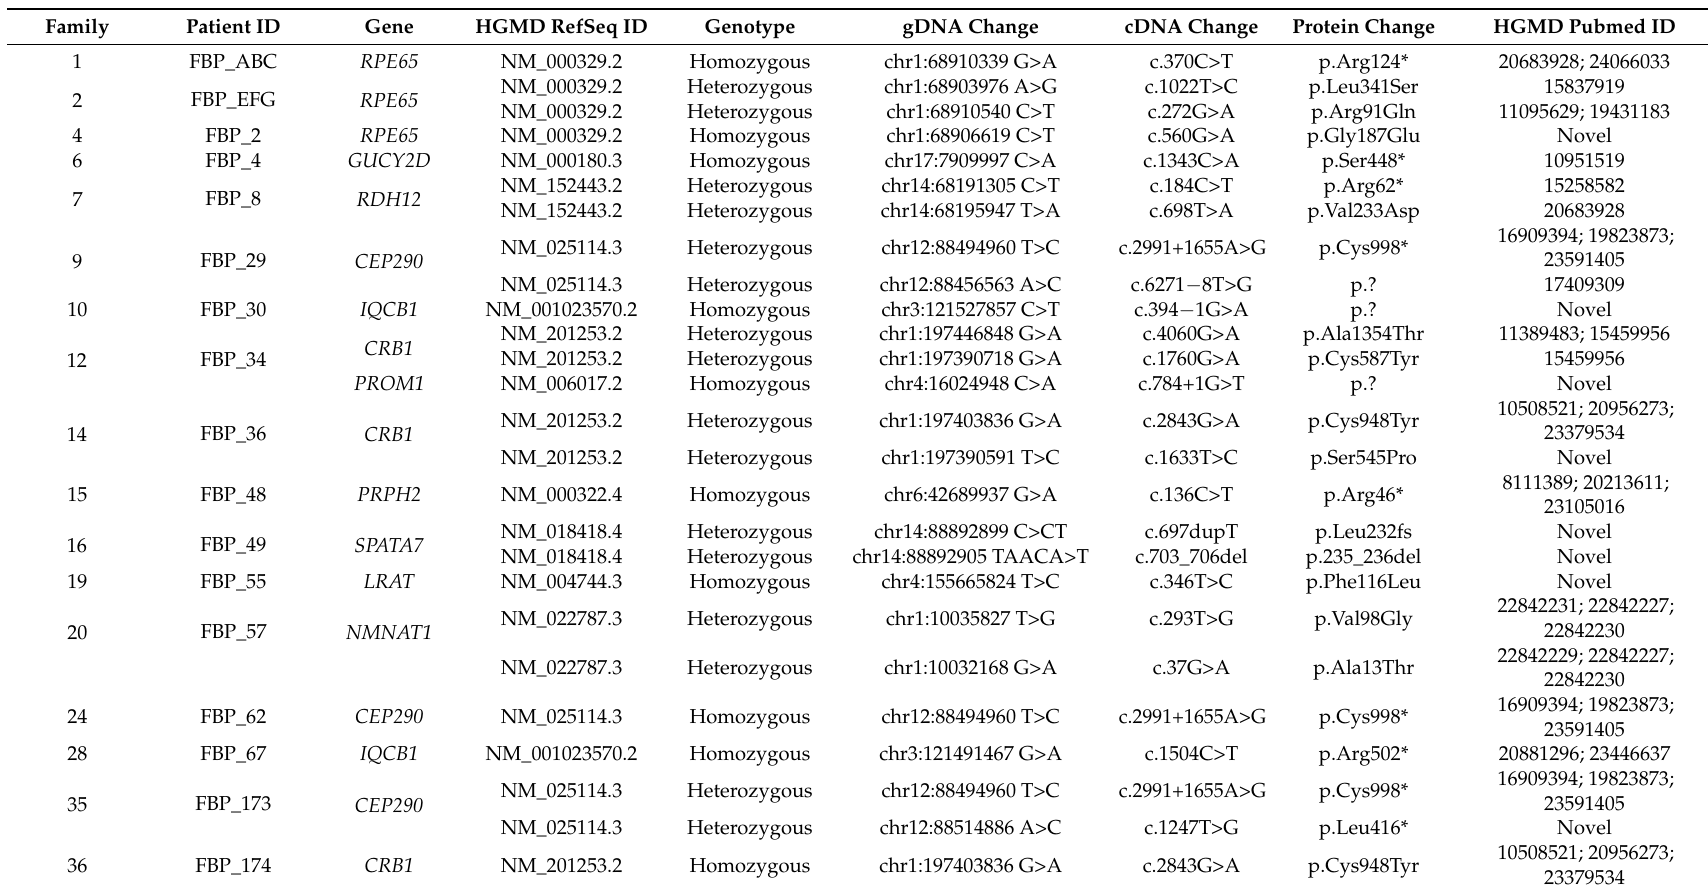
Table 2. 17 unrelated Brazilian probands diagnosed with LCA or early-onset retinal dystrophy and solved by pathogenic mutations in canonical LCA/ early-onset severe retinal dystrophies (EOSRD) disease